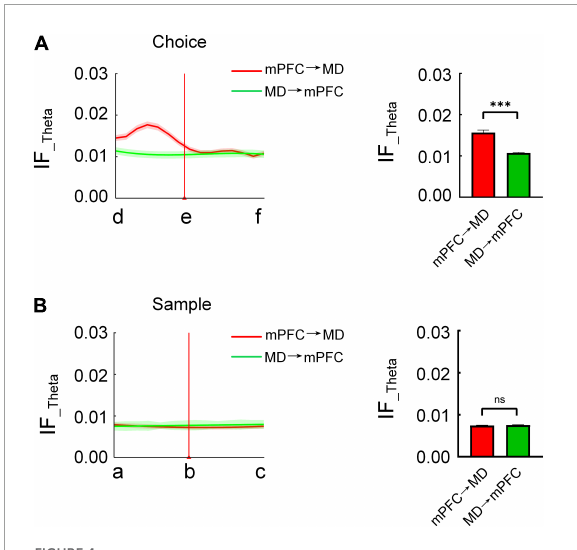
FIGURE4 Directional information flow from mPFC to MD is distinct during the choice phase. (A) The bidirectional information flow between mPFC and MD across subjects ( n = 8 mice) during the choice phase on correctly performed trials. (Left) The red and green curve represents the information flow from mPFC to MD and from MD to mPFC, respectively. (Right) The information flow from mPFC to MD was significantly higher than the reverse (Mann–Whitney test: P < 0.001). (B) Same as (A) , but for sample (Mann–Whitney test: P > 0.05). ∗∗∗ P < 0.001, ns, not